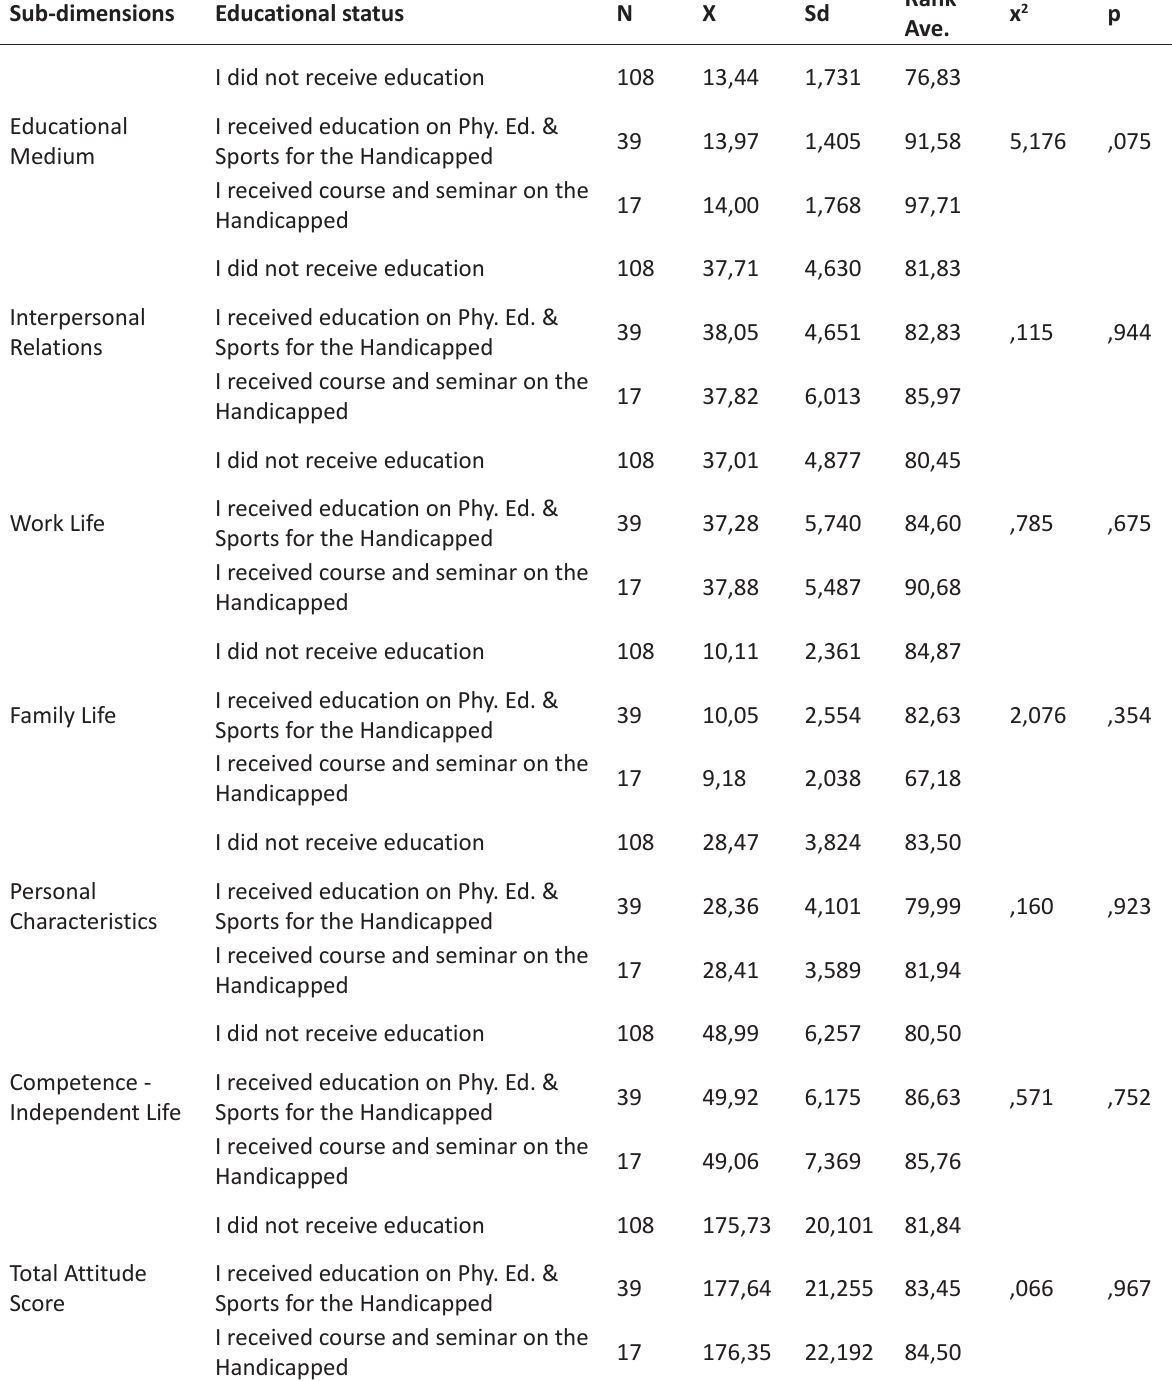
Table 7. Comparison of the Attitudes of the Participants towards the Handicapped according to Having Received Education on Special Education (the Handicapped)